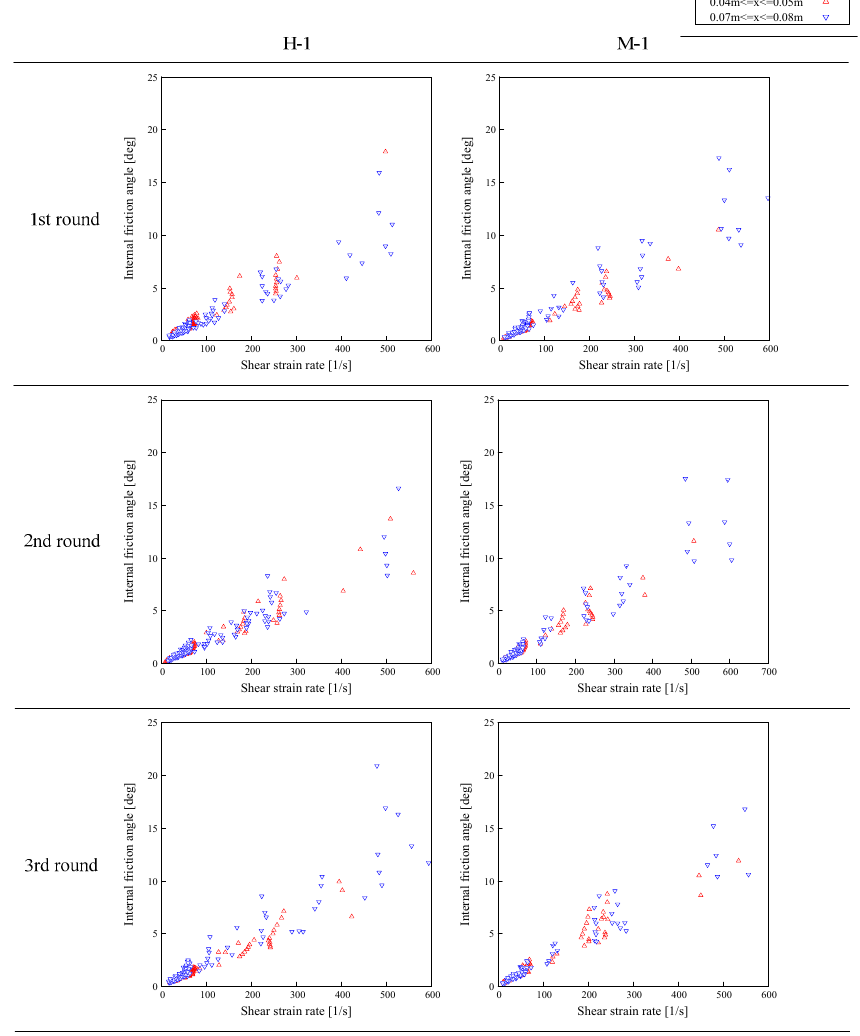
Figure 25. Relationship between the shear strain rate and the internal friction angle. The red mark shows 0.04 m to 0.05 m, as the deceleration range, and the blue mark shows 0.07 to 0.08 m, as the acceleration region.